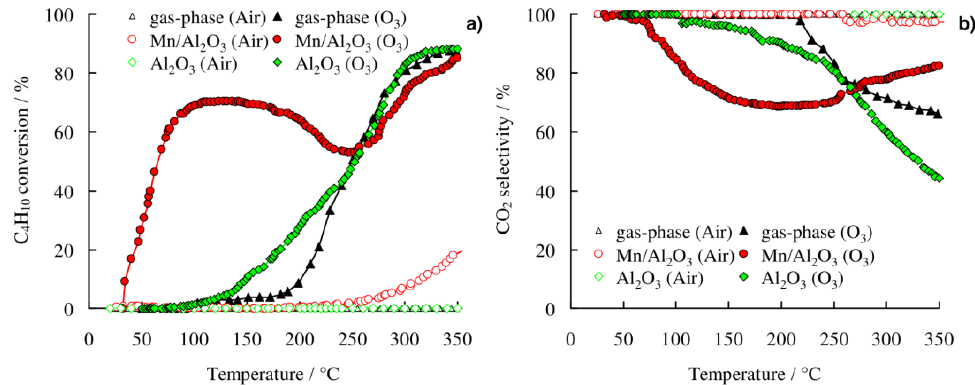
Figure 4. The gas-phase and catalytic oxidation of n -C 4 H 10 by air and air/O 3 mixture: ( a ) n -C 4 H 10 conversion and ( b ) CO 2 selectivity. Conditions: 100 ppm n -C 4 H 10 , air or 450 ppm O 3 , balanced with N 2 ; F total = 750 mL/min (GHSV = 155.000 h − 1 ).